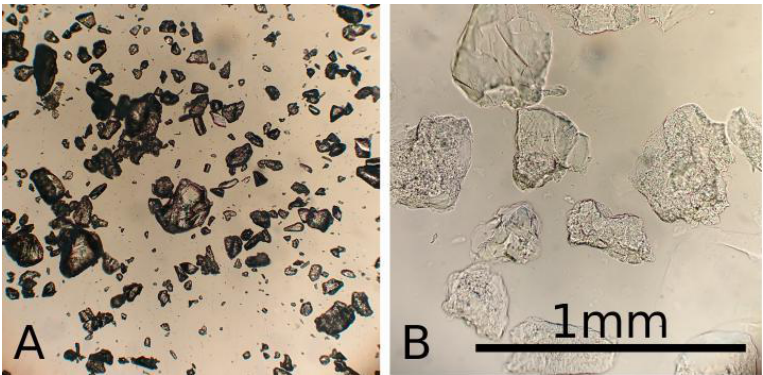
Figure 2. Microscopic image of gelatine granules when dry ( A ) and soaked ( B ) in 100 mM CaCl 2 solution, compared to a reference bar of 1 mm.